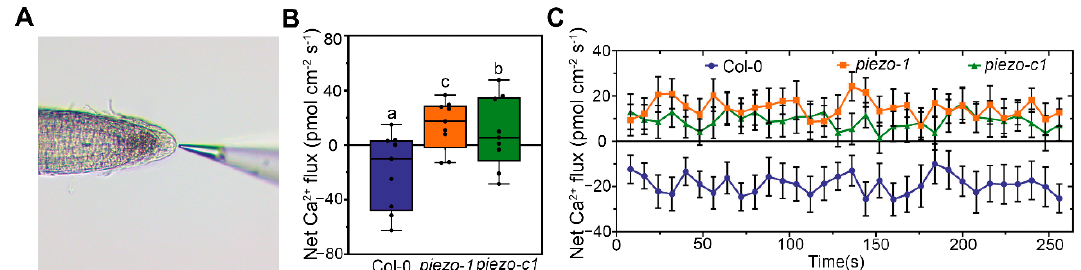
Figure 6. AtPiezo affects the Ca 2+ flux of plant root cap. ( A ) Schematic diagram of the position for Ca 2+ flux measurement using NMT. ( B ) The net Ca 2+ fluxes in Col-0, piezo-1 , and piezo-c1 seedlings that were grown on medium for five days. Boxplots span the first to the third quartiles of the data. A line in the box represents the median ( n = 9). The results were analyzed with one-way ANOVA and Tukey’s multiple comparison test (Different lowercase letters indicate significant differences at p < 0.05) ( C ) Real-time kinetics of Ca 2+ flow in the tip of root cap. Data are presented as mean ± SE ( n = 5).